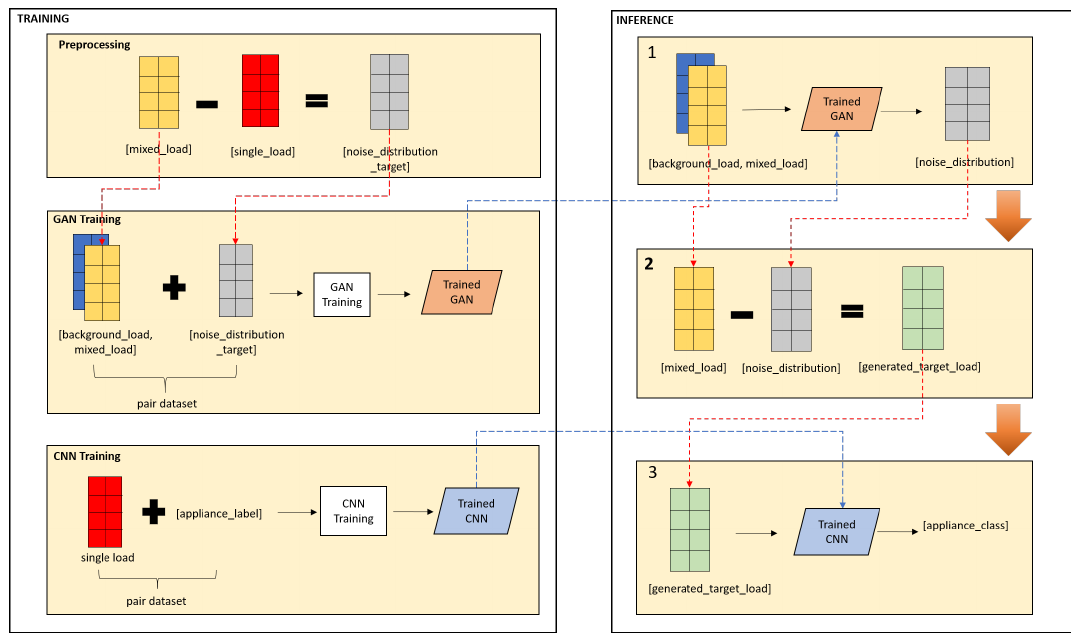
Figure 3. Framework of proposed